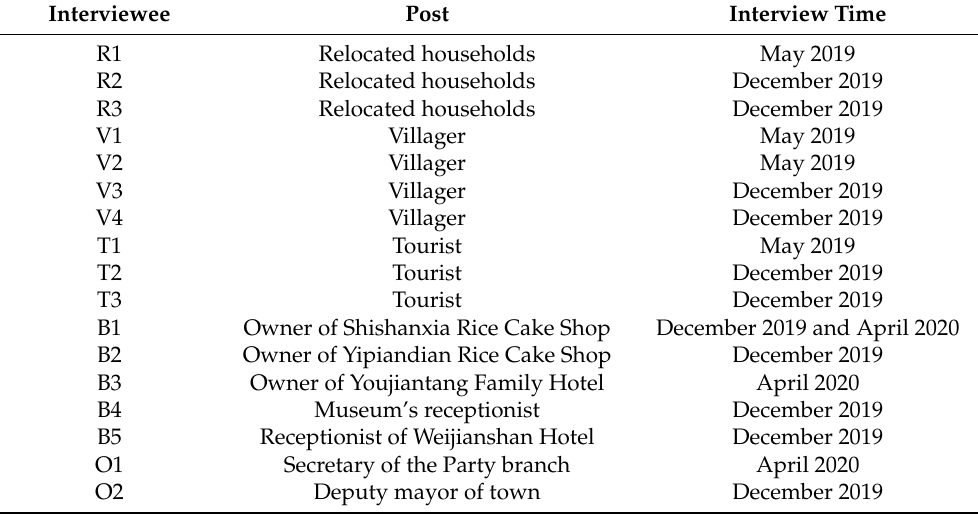
Table 1. Basic information of